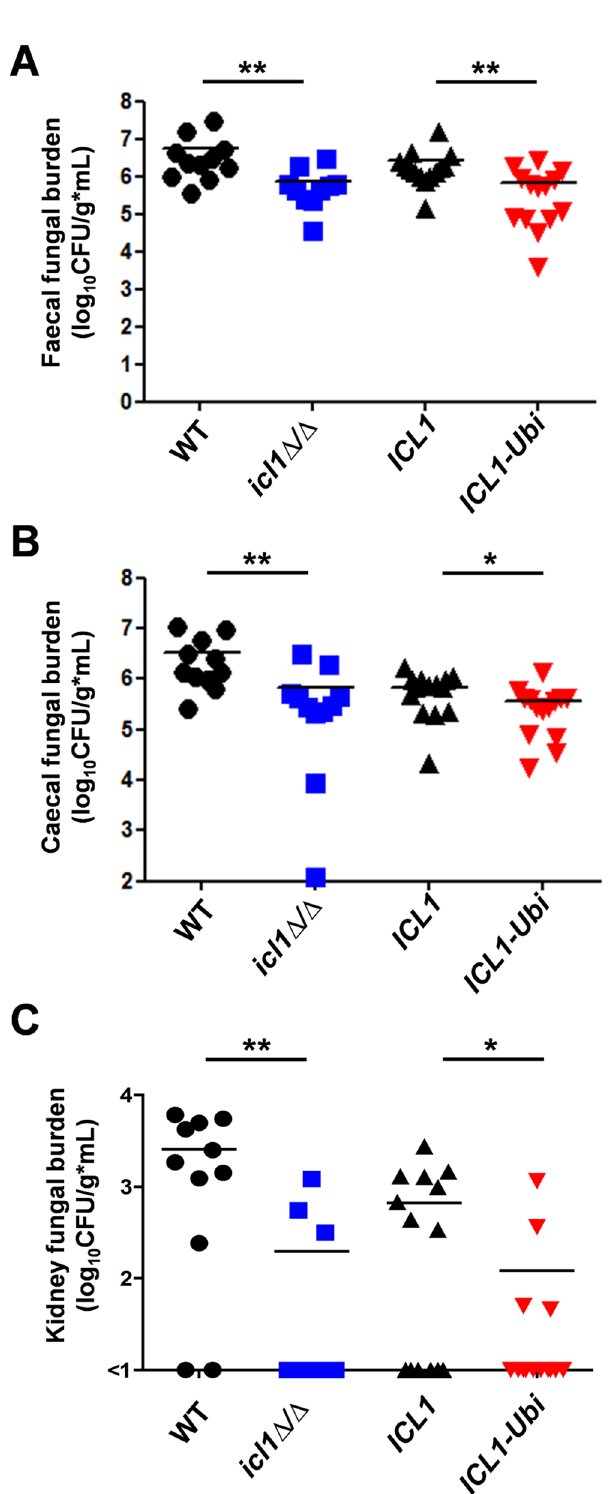
Fig 5. Metabolic flexibility in C . albicans enhances gastrointestinal colonization. Pairs of NAT1- marked C . albicans strains were introduced into mice by oral gavage and fungal burdens (CFUs) for the nourseothricin resistant and sensitive strains determined in the faeces (A), caecum (B) and kidneys (C) after 14 days. The analysed strains were: WT, SC5314 or DCY95; icl1 Δ / Δ , DCY65 or DCY152; ICL1 , DCY75 or